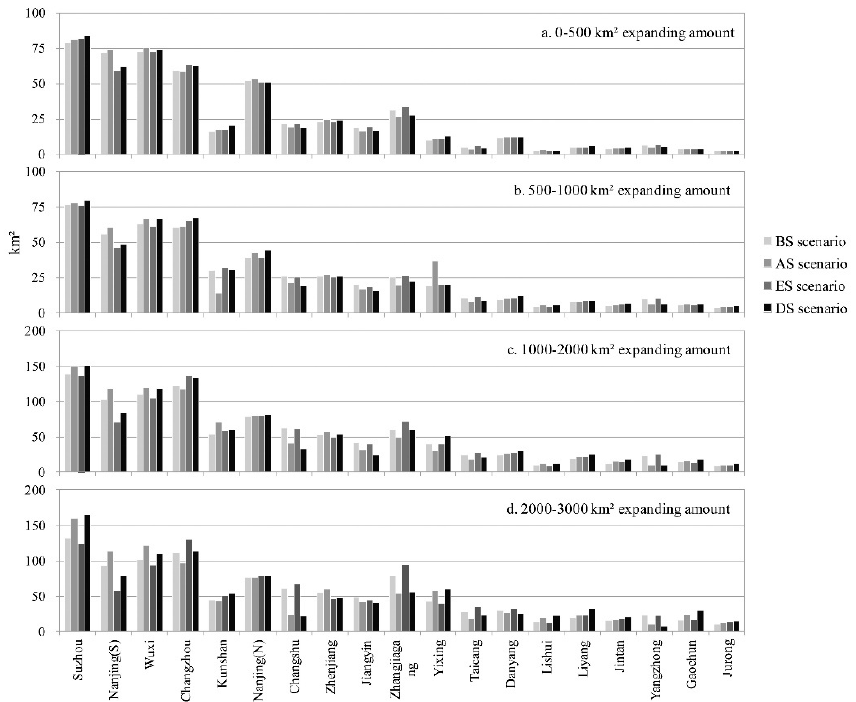
Figure 8. Expanding amounts of each city under different scenarios and total USE amounts. The cities are sorted from large to small based on their original area.